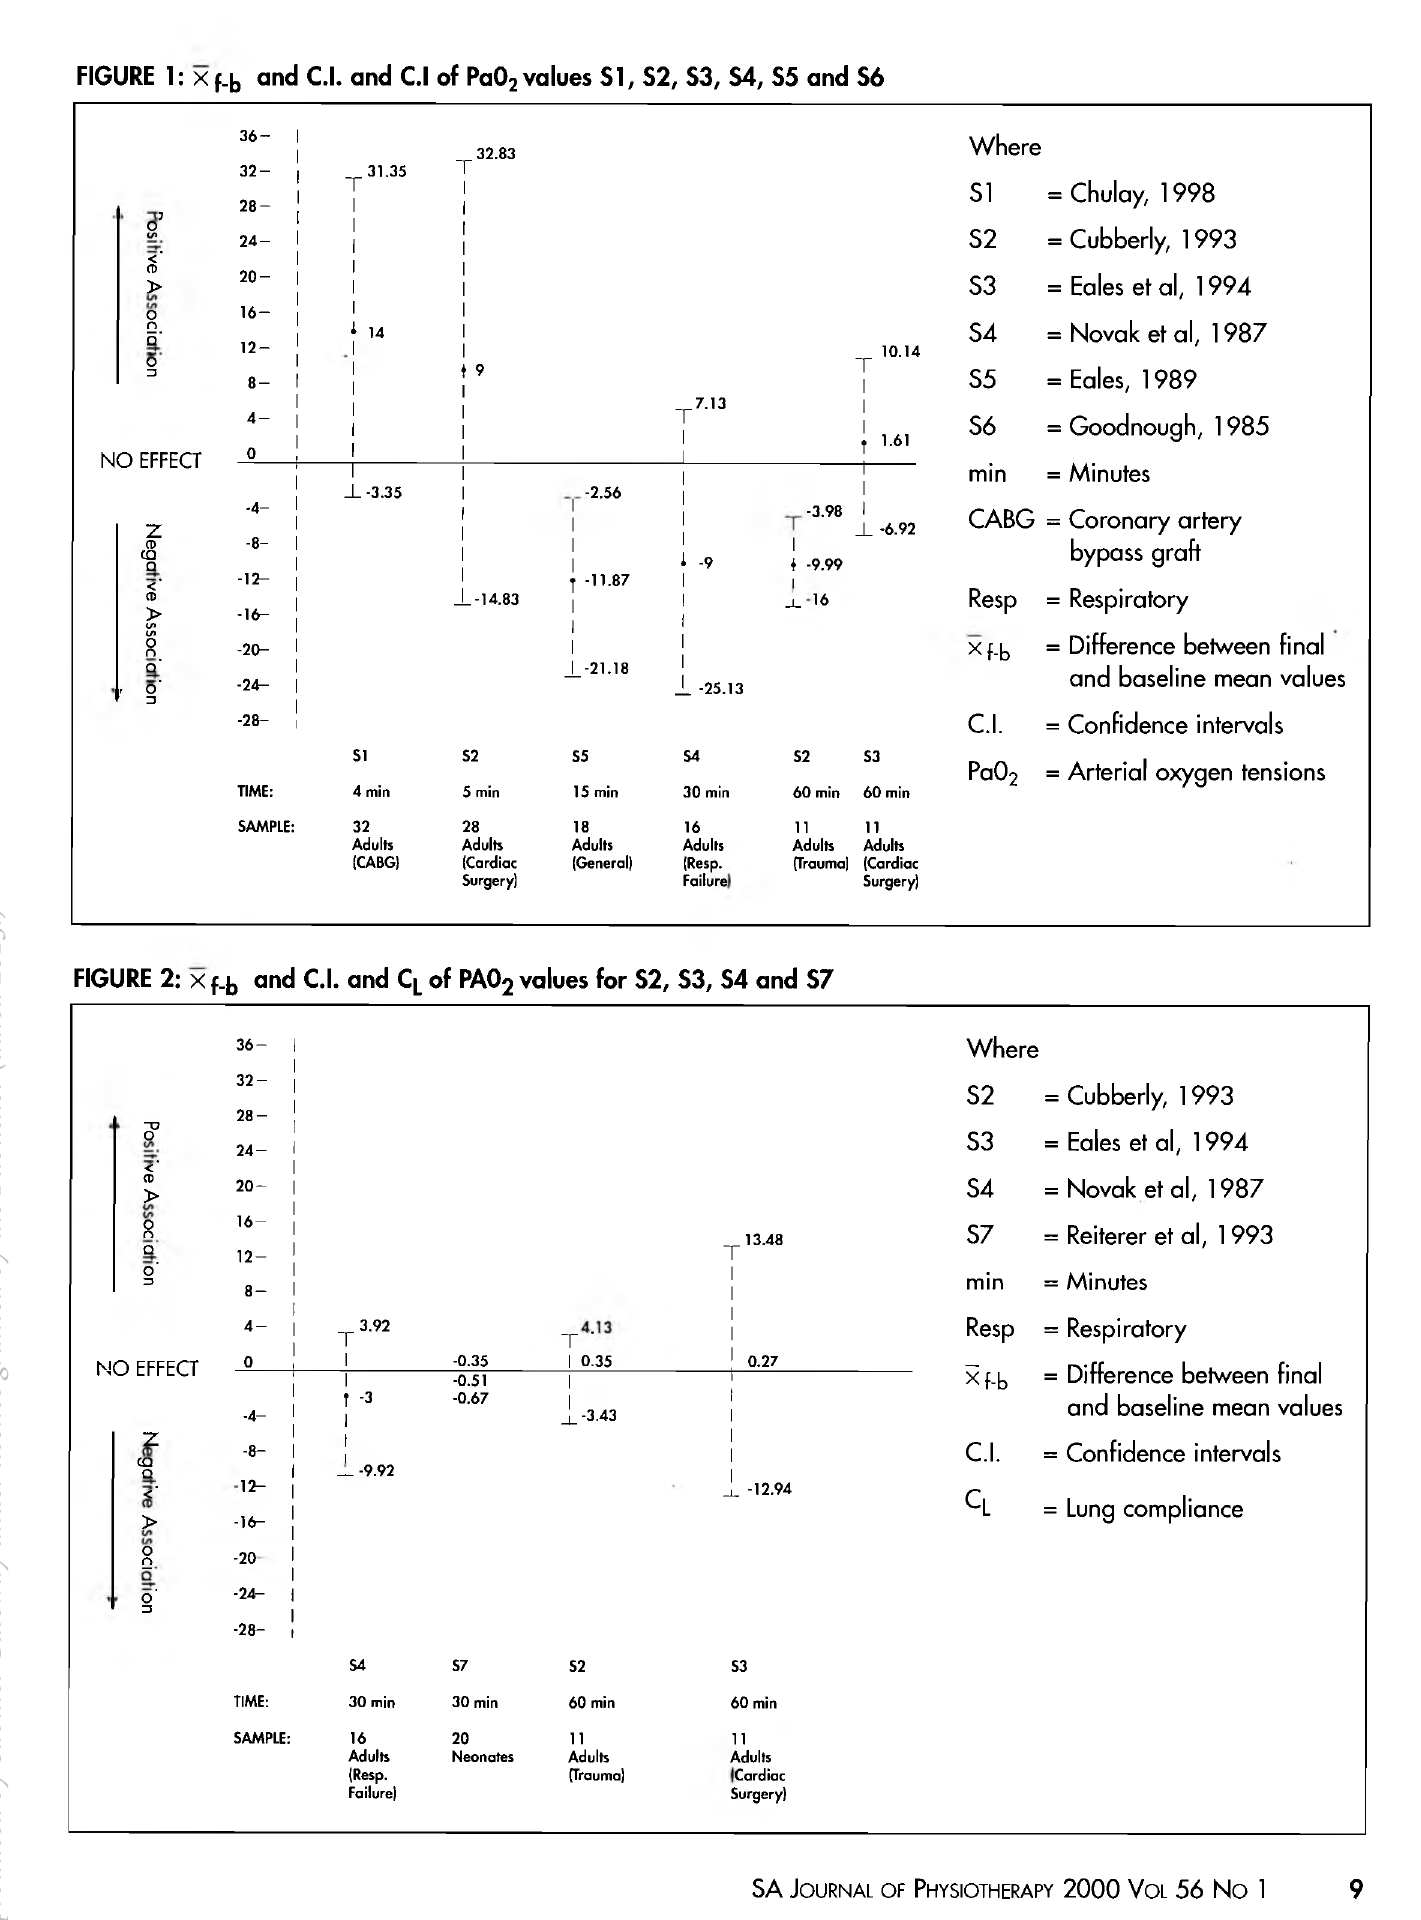
FIGURE 1: X f.|, and C.l. and C.l of Pa02 values SI, S2, S3, S4, S5 and S6